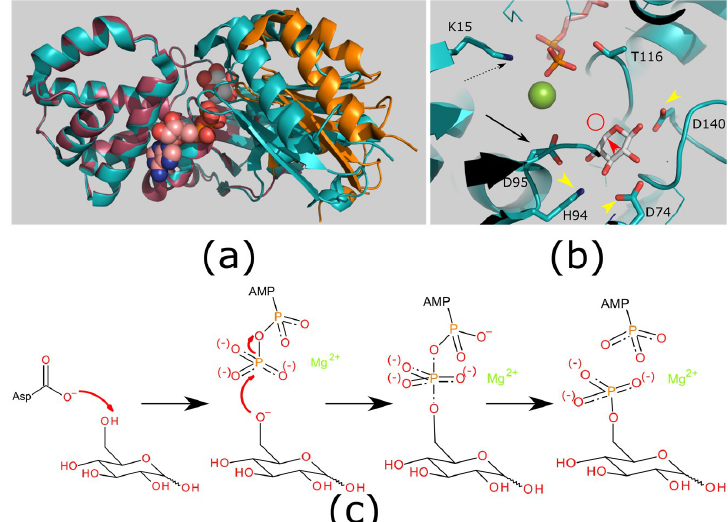
Figure 2. Structure and mechanism of hexokinases. ( a ) Hexokinases show a conformational change on binding substrate to create the ATP binding site. Structures of an apo enzyme (raspberry/orange; PDB ID: 2E2N) and ligand bound enzyme (teal; PDB ID: 2E2Q [43]). Ligands xylose (white carbons; substrate analog) and ADP (carbons pink; product). The protein structures have the large domain (left: teal/raspberry) superimposed to highlight the movement in the small domain (teal/orange). There is a substantial rigid body closing of the domains to enclose the substrate. ( b ) Catalytic mechanism.